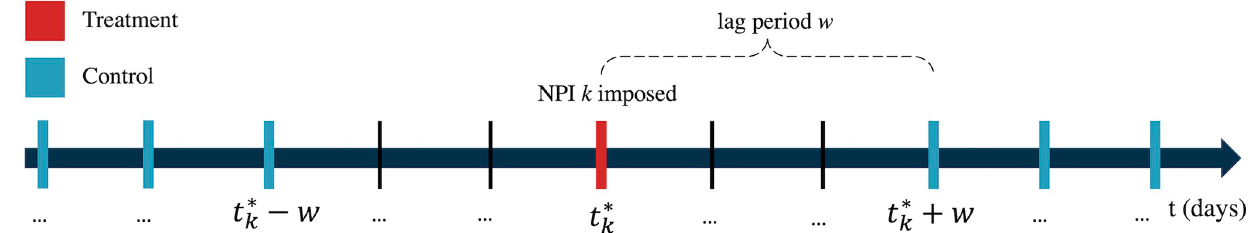
Fig 1. Schematic presentation of the study design. Vertical lines represent days. We denote day t � considering that this NPI was not active the day before (i.e., event date). The treatment group for NPI k consists of t � are the remaining days (in blue) outside the time interval t �